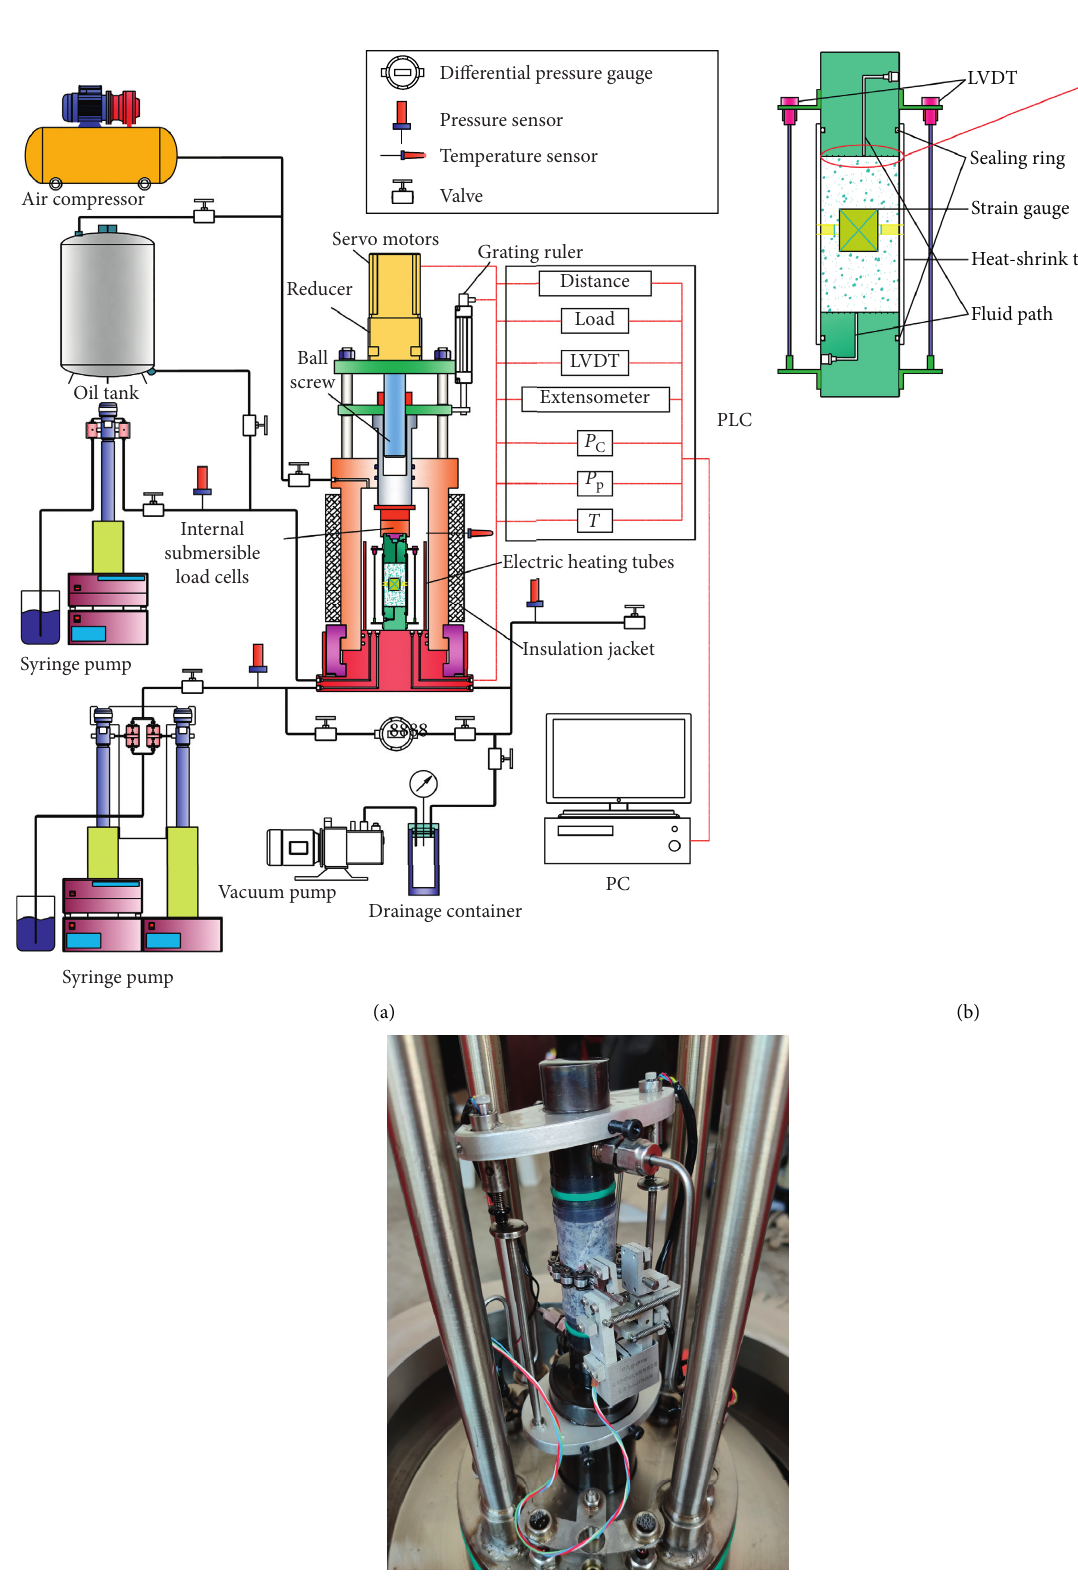
Figure 2: The test apparatus: (a) schematic diagram of the apparatus [26]; (b) schematic diagram of the installed granite specimen; (c) close- up view of the installed granite